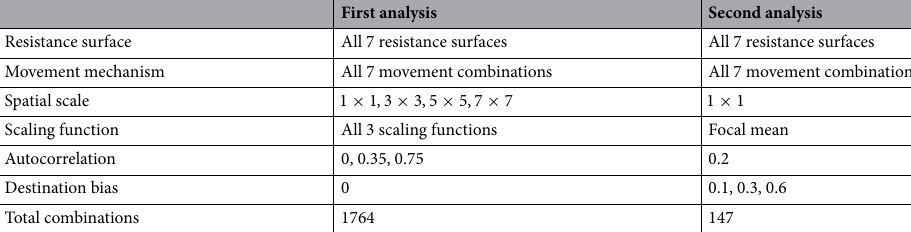
Table 1. The selection of parameters used to produce the simulated connectivity maps with Pathwalker. In both analyses, all 7 resistance surfaces are tested, and all 7 movement combinations are used (energy, attraction, risk, and their pairwise and three-way combinations). In the first analysis, the spatial scale, scaling function and degree of autocorrelation are varied; in the second analysis, these three parameters are fixed whilst the degree of destination bias is